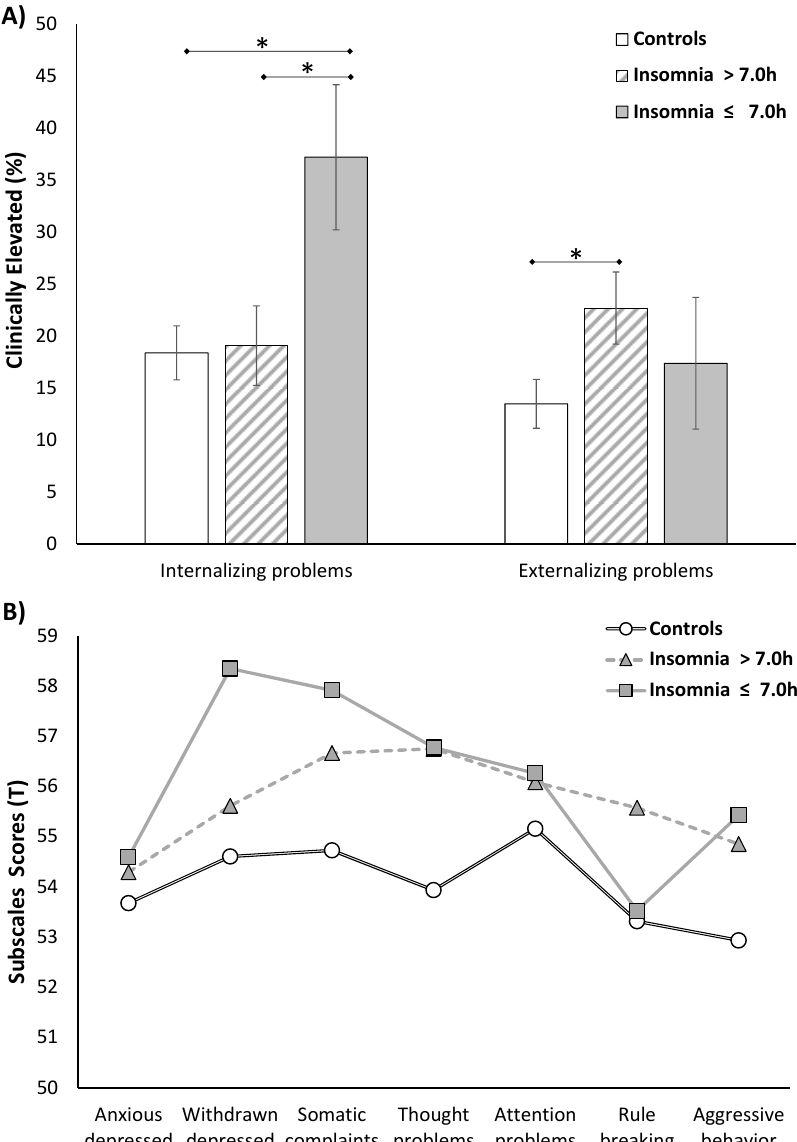
Figure 2. Behavioral profiles of insomnia symptoms phenotypes based on objective sleep duration. ( A ) Adolescents with insomnia symptoms who slept objectively ≤ 7 h showed clinically elevated internalizing problems as compared to controls; in contrast, adolescents with insomnia symptoms who slept objectively >7 h showed clinically elevated externalizing problems as compared to controls; ( B ) The behavioral profile of internalizing and externalizing subscales was significantly different between insomnia phenotypes when compared to controls. Adolescents with insomnia symptoms who slept objectively ≤ 7 h had significantly higher withdrawn depression, somatic complaints, thought problems (rumination) and aggressive behaviors (mood regulation) as compared to controls, while adolescents with insomnia symptoms who slept objectively >7 h had significantly higher somatic complaints, thought problems (rumination), rule-breaking and aggressive behaviors (acting-out aggression) as compared to controls. All data adjusted for sex, age, race, socioeconomic status, body mass index percentile, morning-eveningness questionnaire score, apnea/hypopnea index and periodic limb movement index.